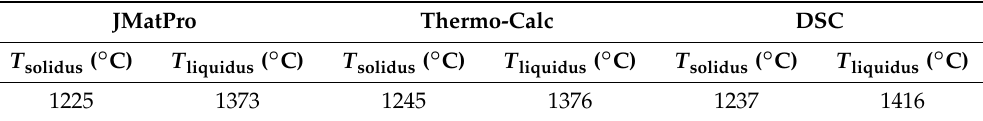
Table 2. Chemical composition (wt. %) and phase transformation temperatures of X210Cr12 steel.